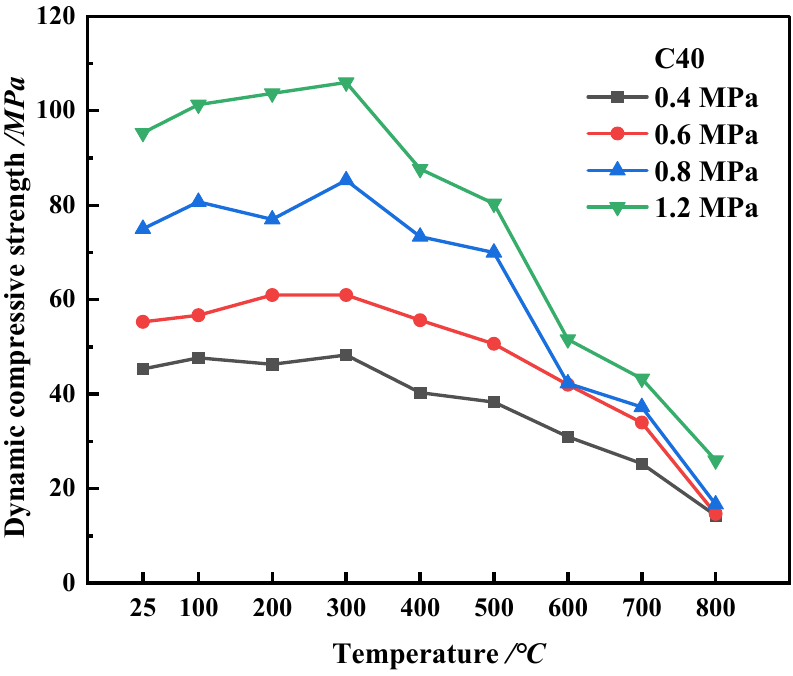
Figure 12. Dynamic compressive strength curves of concrete with grade C40.